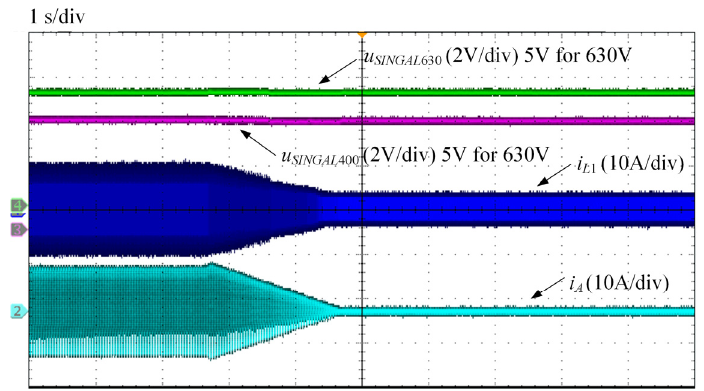
Figure 23. Waveforms when 4 kW air conditioner shutdown in on-line mode.